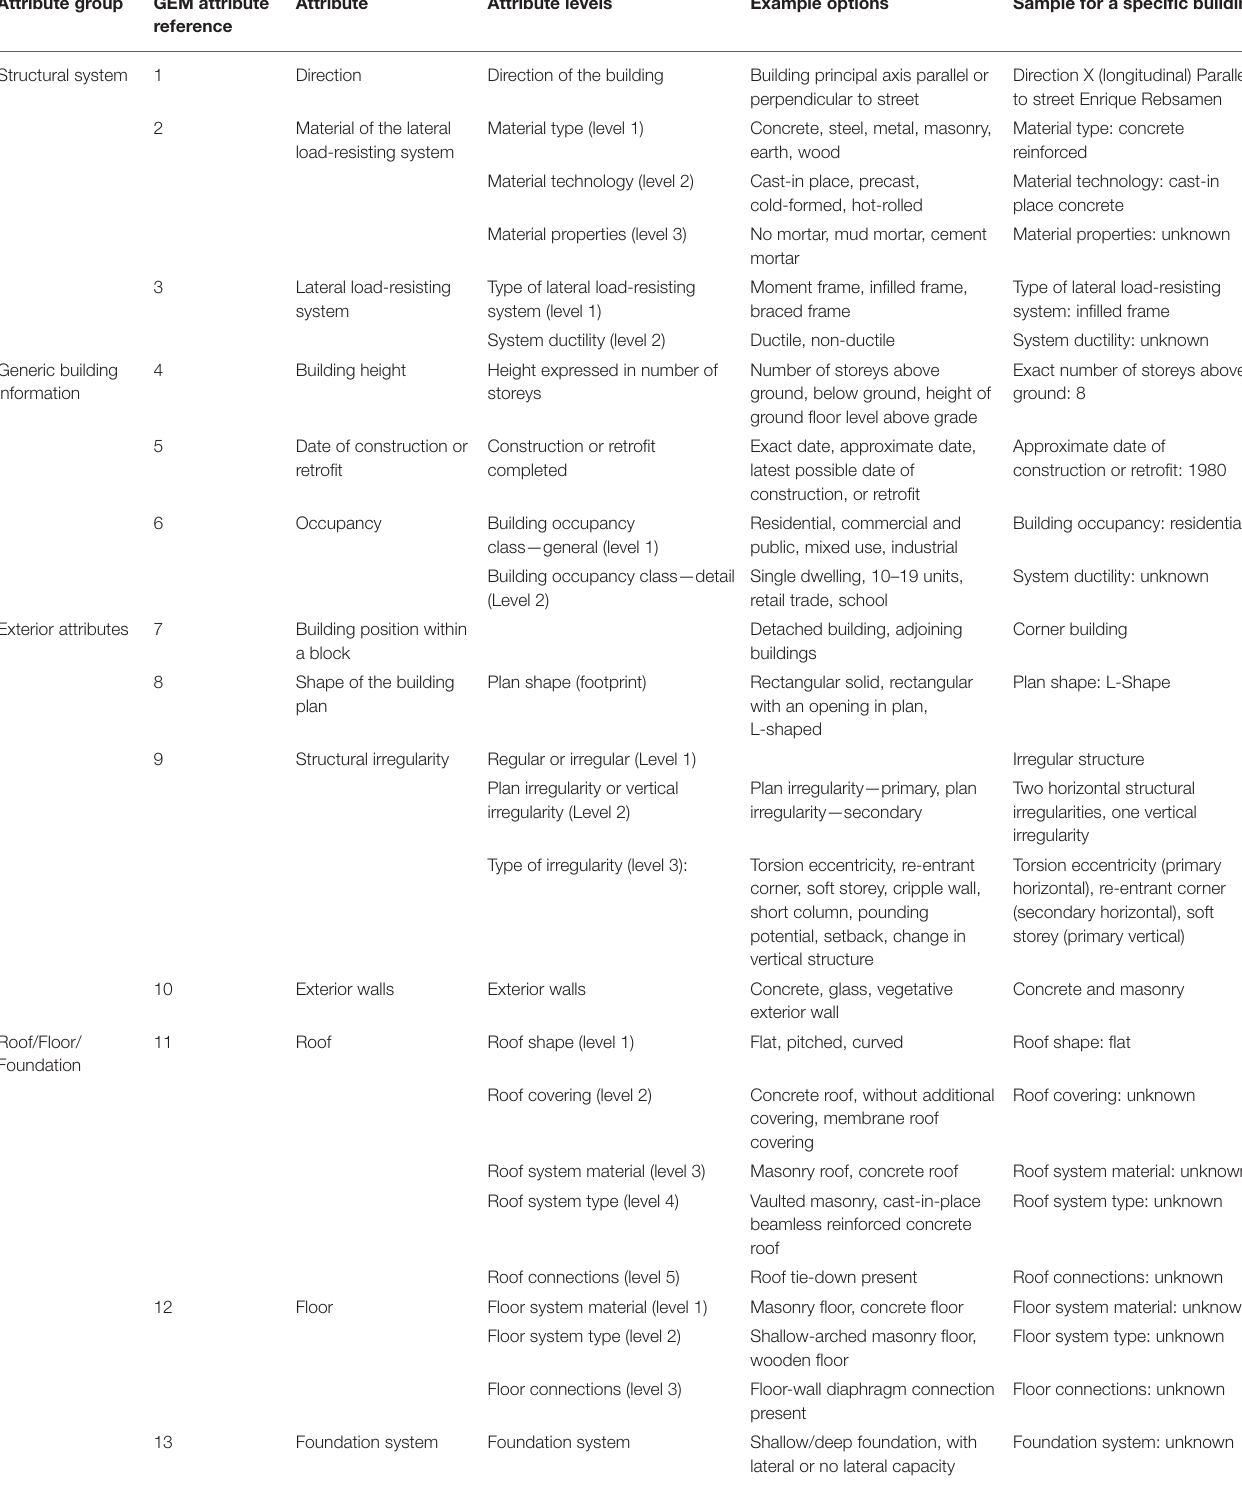
TABLE 1 | Overview of the GEM building taxonomy